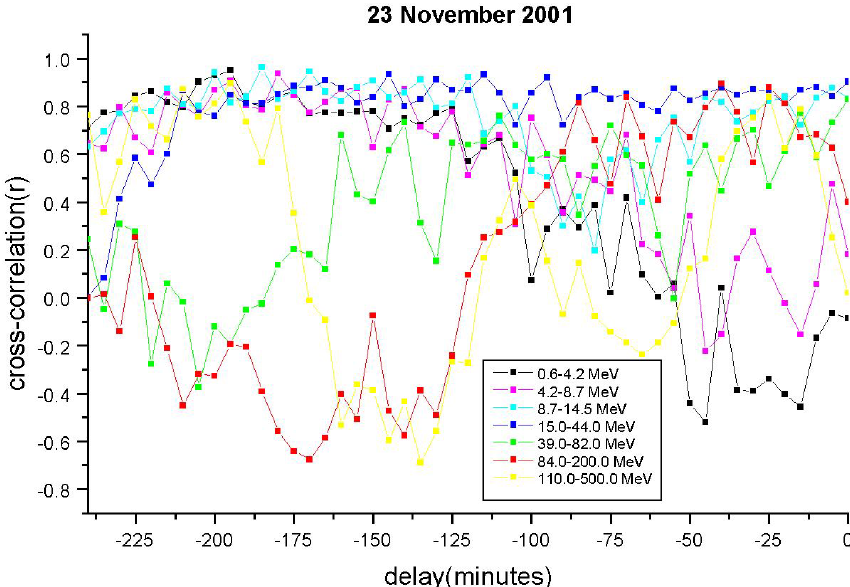
Fig. 10. Cross-correlation coefficients between A(t) and differential J 1 / 2 (t − τ) calculated for the first hour of 23 November PCA event (00:25 UT–01:25